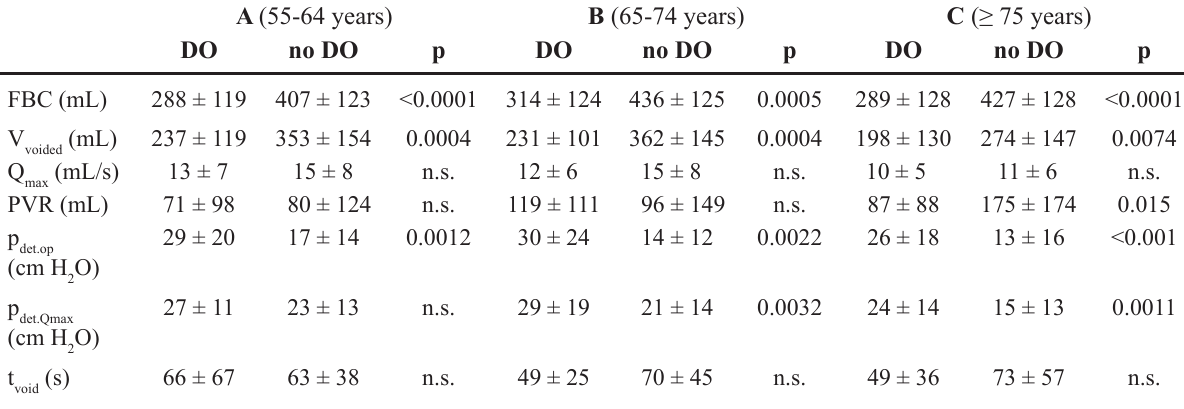
Table 6 – Influence of detrusor overactivity (DO) on the urodynamic parameters during pressure-flow study (PFs).